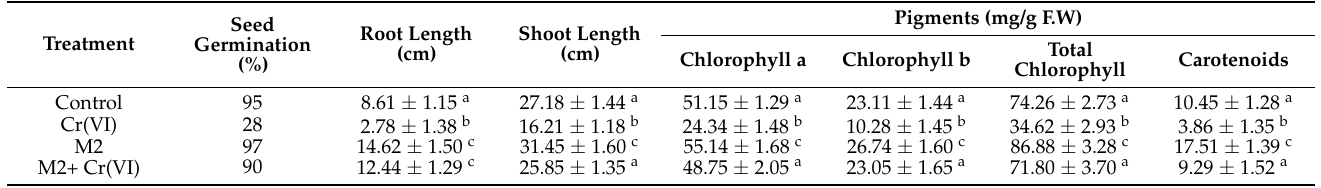
Table 4. Effect of Cr(VI) and the rhizobacterial strain M2 on seed germination, growth, and pigments of V. radiata